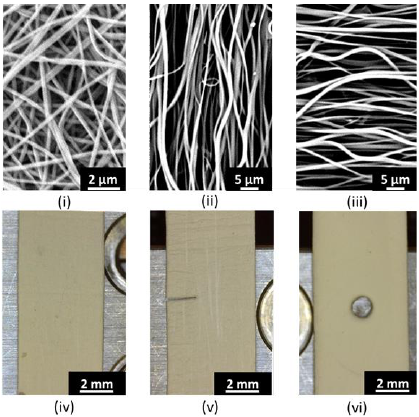
Figure 1. PA6 membranes studied within this work. Three different nanofiber orientations com- pared to the tensile direction are considered: ( i ) random, ( ii ) parallel, and ( iii ) perpendicular. Three specimen types were considered for every fiber orientation: ( iv ) pristine, ( v ) line rupture, and ( vi ) hole perforation.